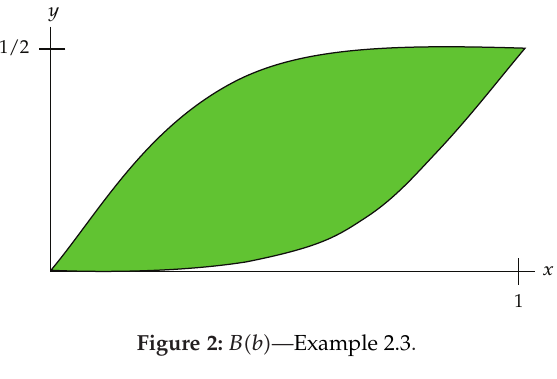
Figure 2: B (cid:2) b (cid:3) —Example 2.3.